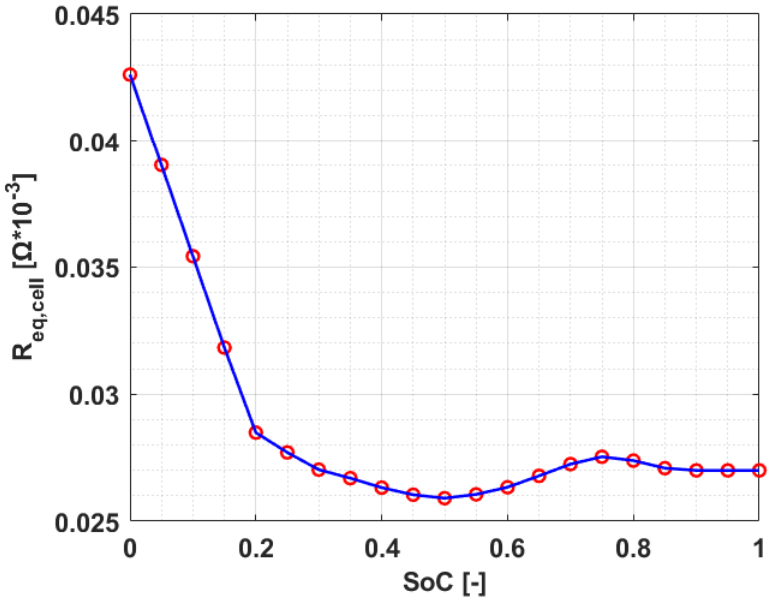
Figure 6. Battery cells resistance as a function of the state of charge .